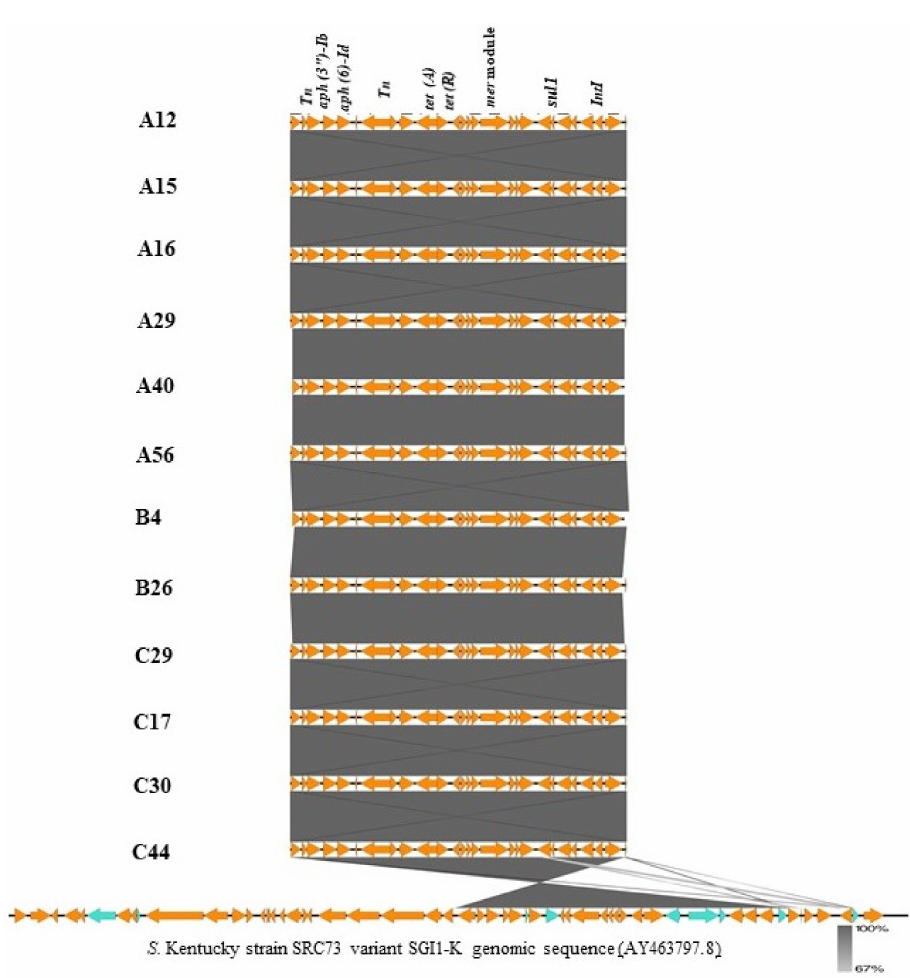
Figure 4. Alignment of 20 kb region of Salmonella genomic islands of 12 study strains (cluster I) with the SGI1-K reference se- quence, created using EasyFig. Orange arrows represent coding regions of genes; blue arrows represent non-coding